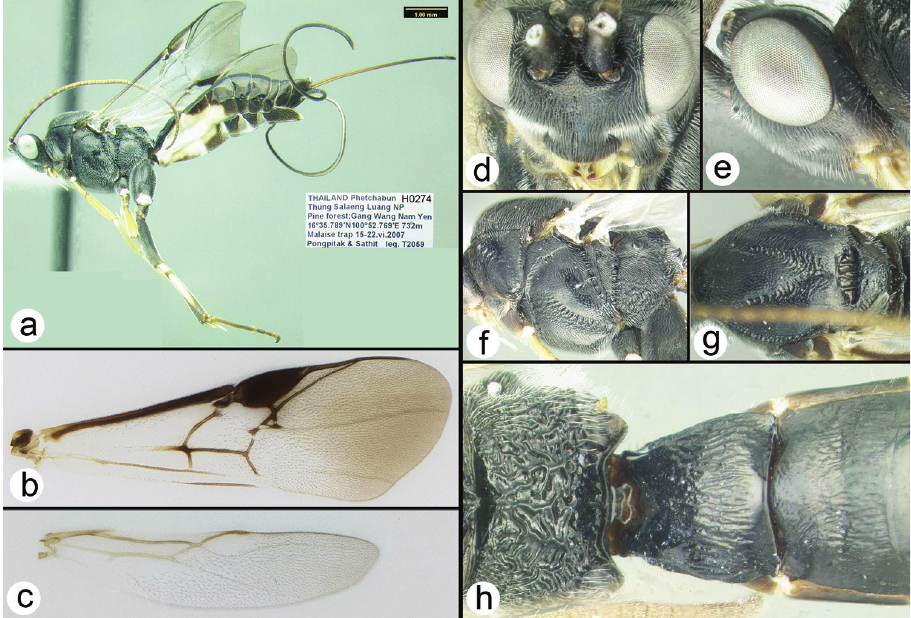
Figure 3. Asperagathis aspera , holotype female: a lateral habitus b fore wing c hind wing d dorsal head e lateral head f lateral mesosoma g dorsal thorax h propodeum and metasomal terga 1-2.